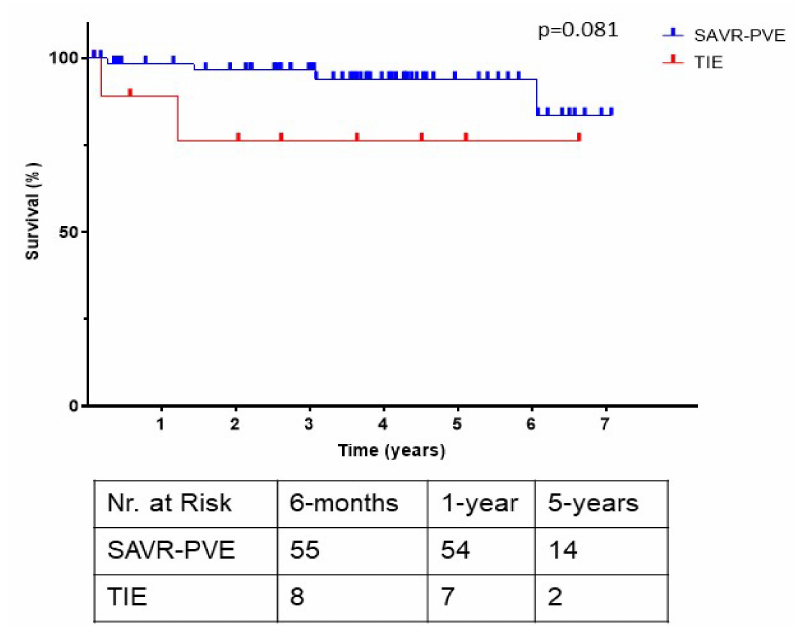
Figure 3. Kaplan–Meier survival curves of the SAVR–PVE group compared with the TIE group, with the number of patients at risk in tabular form. SAVR–PVE, prosthetic valve endocarditis following surgical aortic valve replacement; TIE, prosthetic valve endocarditis following transcatheter aortic valve